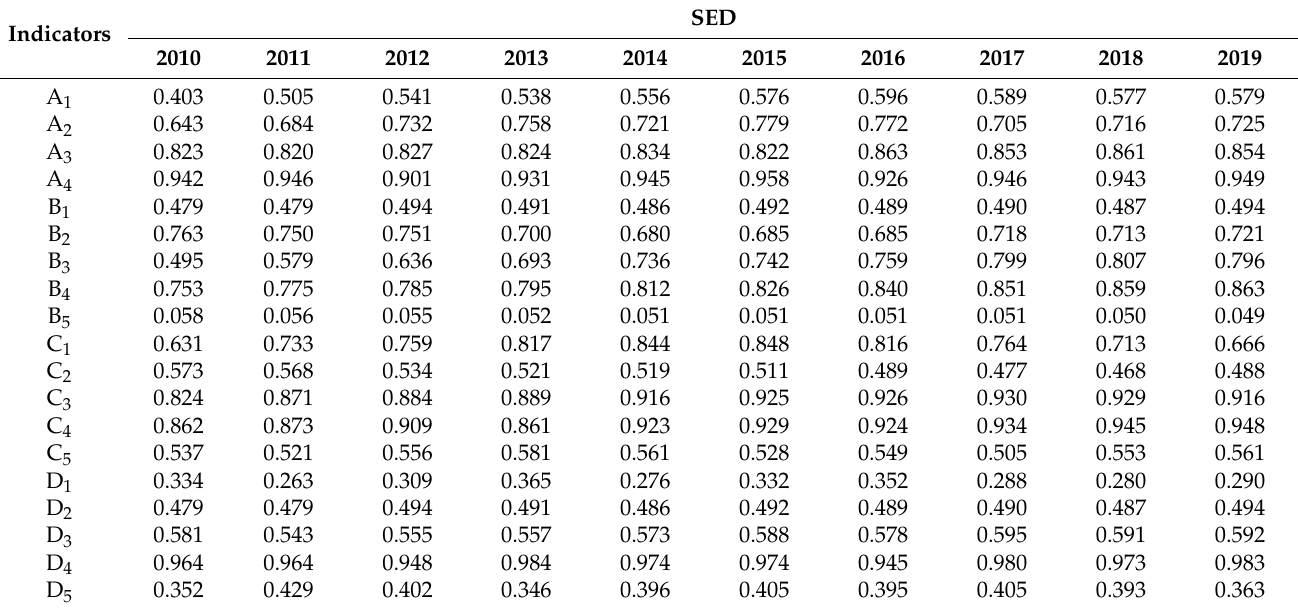
Table 4. The SED of all indicators from 2010 to 2019.